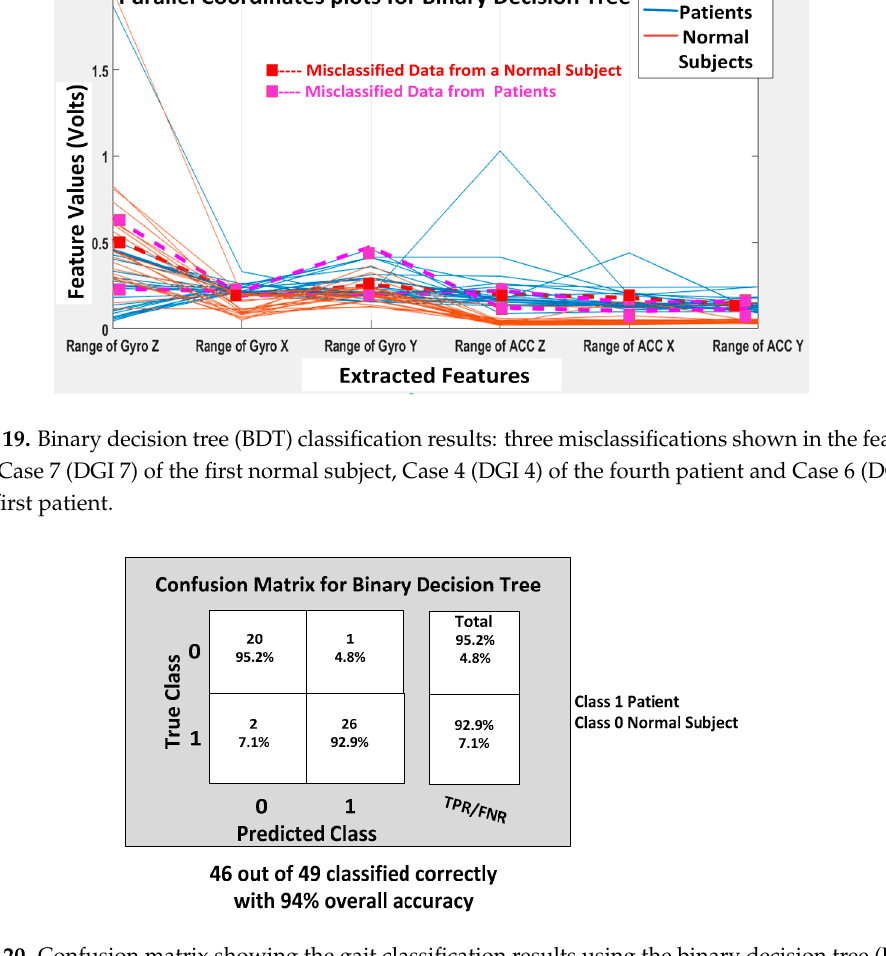
Figure 20. Confusion matrix showing the gait classification results using the binary decision tree (BDT) classification model with the true positive rate (TPR) and false positive rate (FPR).